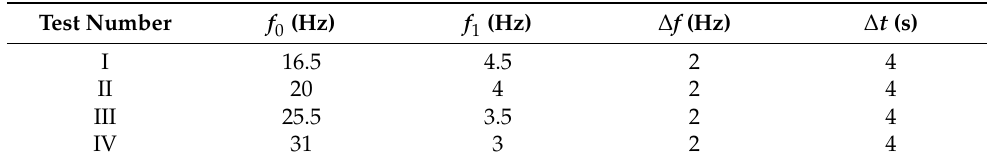
Table 2. GCr15 steel tube separation experimental